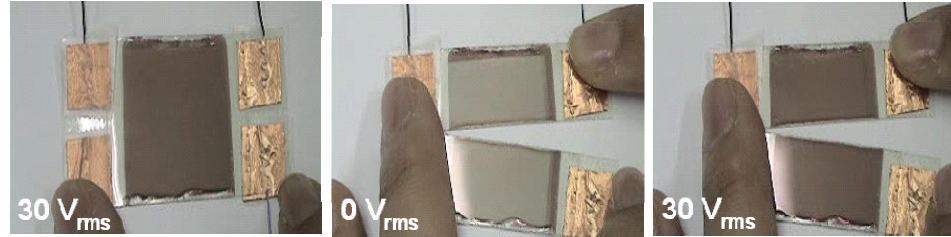
. Right: after trimming at 30 V rms